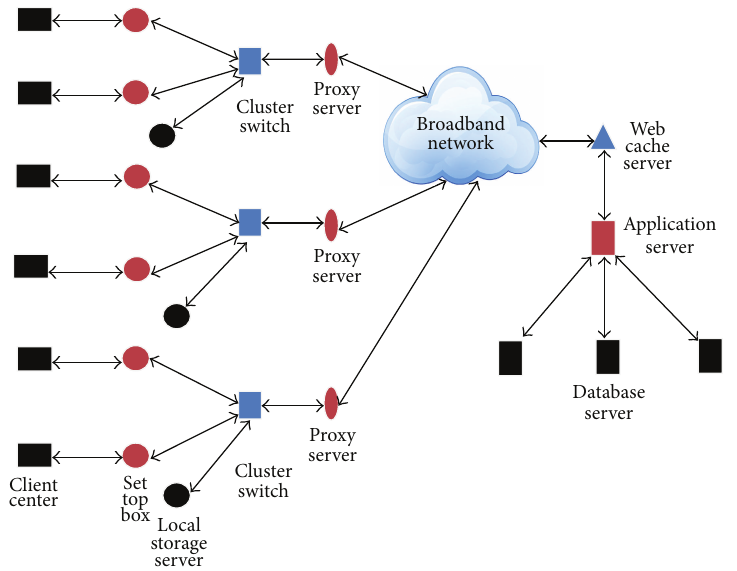
Figure 1: Distributed hierarchy system.